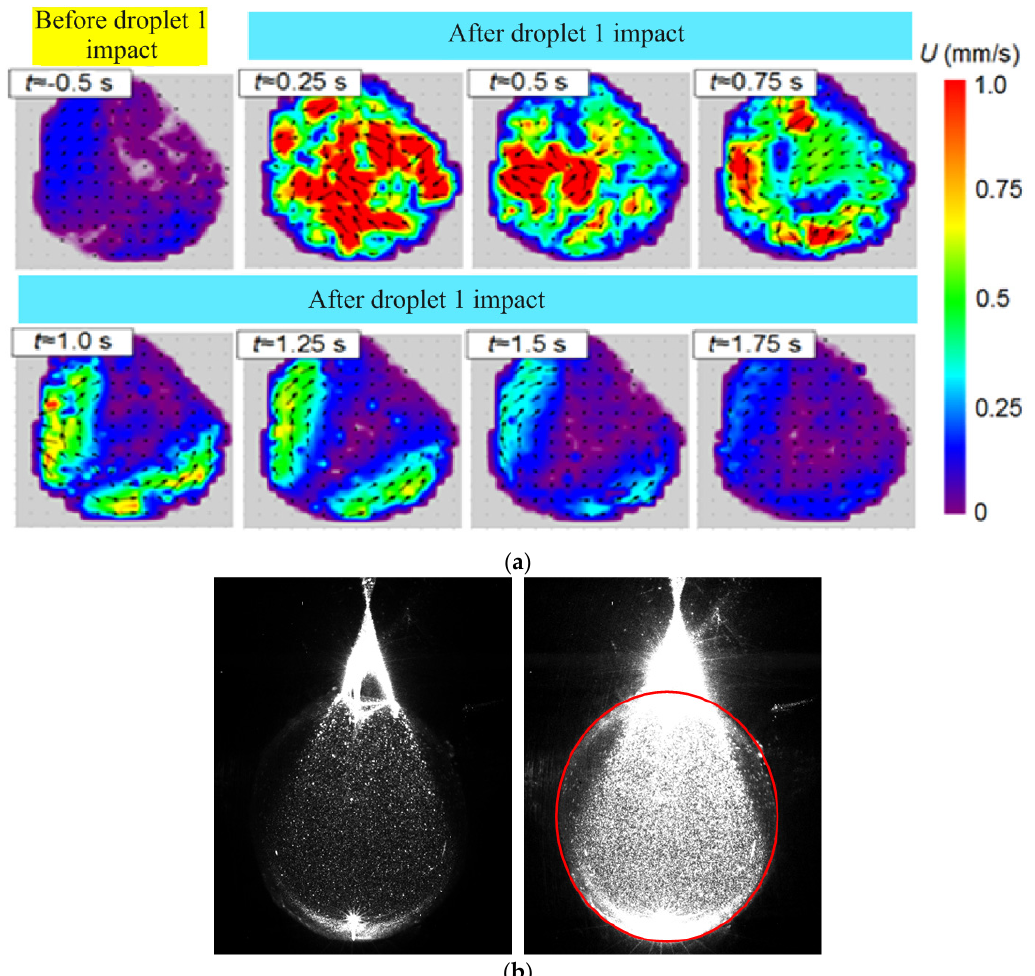
Figure 6. ( a ) Instantaneous velocity fields at the interaction of two drops (PIV measurement, starting point t = 0 s corresponds to droplet 1 falling time, V 02 = 40 μ l; V 01 = 2.5 μ l; T w = 20 °C); ( b ) image of drop 2 before (left) and after (right) image lightening in the image editor (the red line indicates the contour of drop 2).